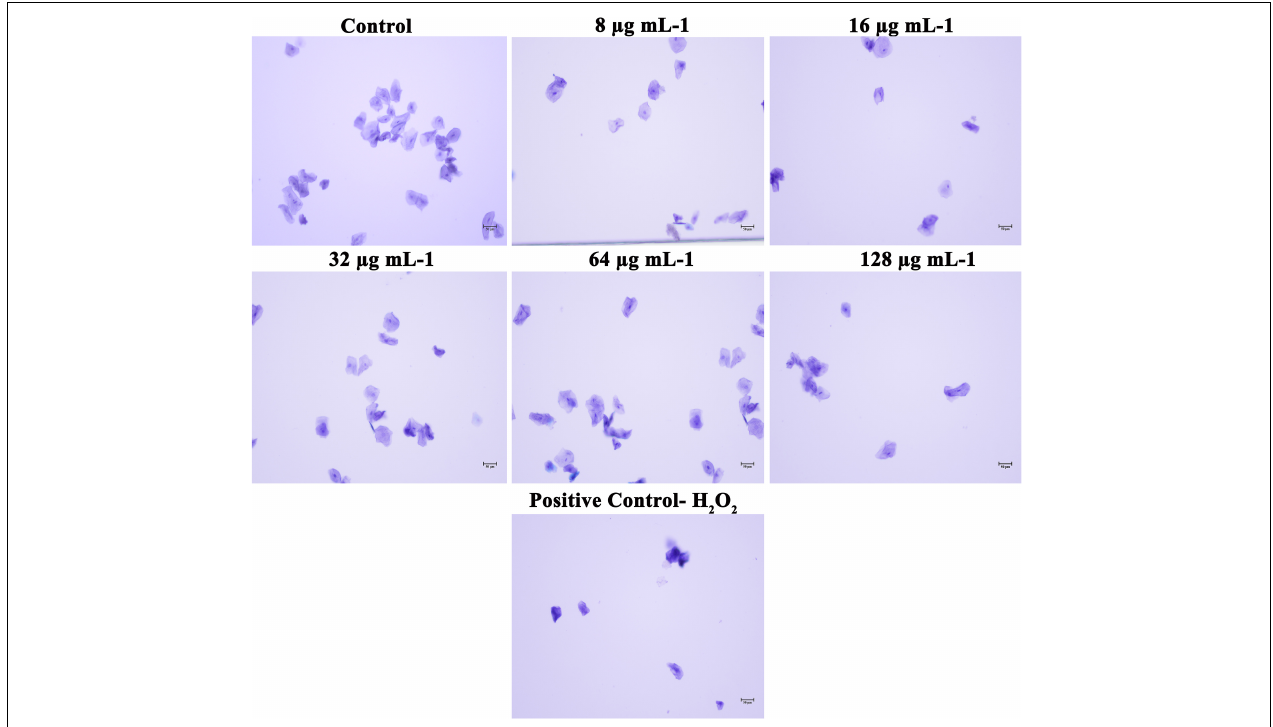
FIGURE 10 | Effect of piperine on HBECs. HBECs treated with 8, 16, 32, 64 and 128 µ g mL - 1 of piperine were found to be health and normal, as the control cells whereas HBECs treated with H 2 O 2 were found to be completely